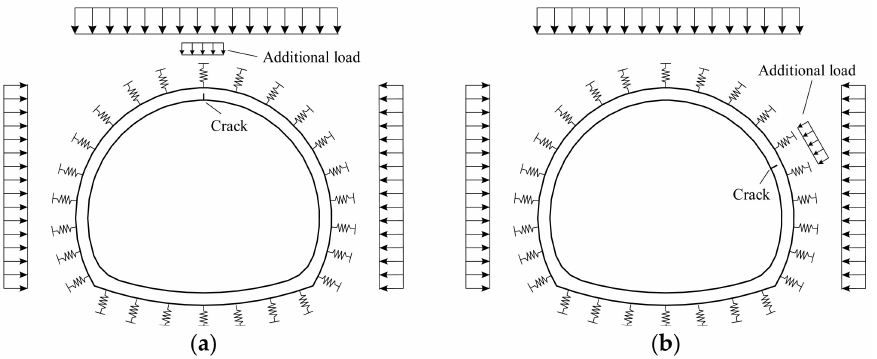
Figure 8. Schematic diagrams of the calculation model: ( a ) crack at the arch crown, ( b ) crack at the arch waist.